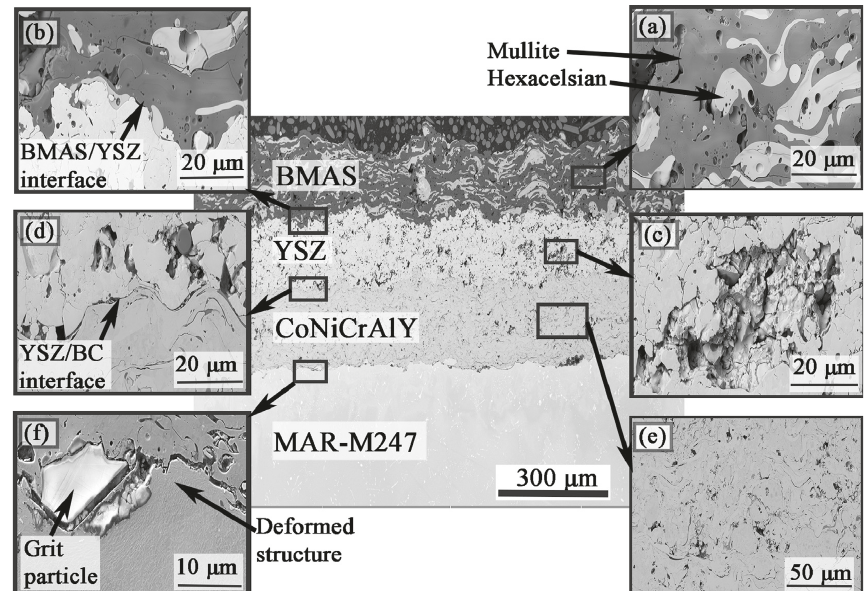
Figure 1: The microstructure of the TEBC system deposited onto the MAR-M247 superalloy substrate. List of insets: (a) detail of the mullite + hexacelsian upper layer; (b) the mullite + hexacelsian/YSZ interface; (c) detail of the YSZ interlayer; (d) the YSZ/BC interface; (e) the CoNiCrAlY BC; (f) the BC/MAR-M247 interface with Al 2 O 3 grit particle.